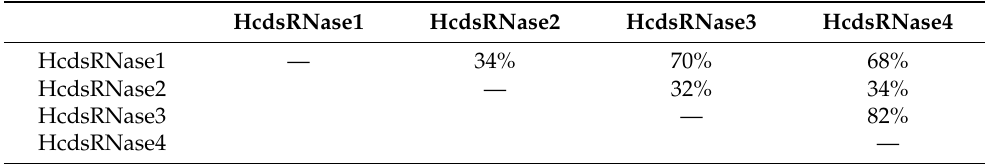
Table 2. Identities among HcdsRNase protein sequences of H. cunea .